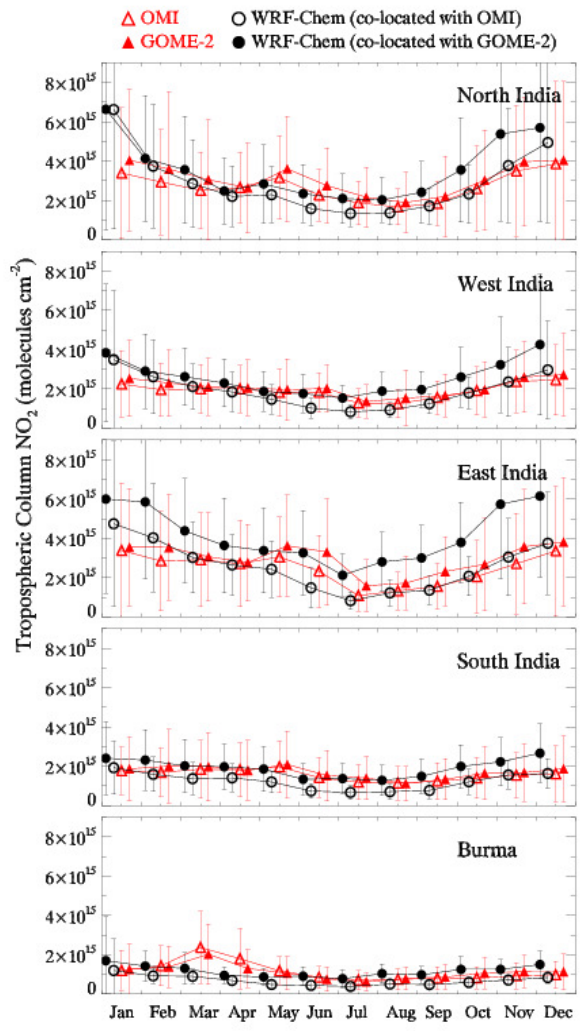
Fig. 16. Seasonal variations in WRF-Chem simulated, OMI and Figure 16: Seasonal variations in WRF-Chem simulated, OMI and GOME-2 retrieved 1352 GOME-2 retrieved tropospheric column NO 2 values over the re- tropospheric column NO 2 values over the regions defined in Figure 1. 1353 gions defined in Fig.